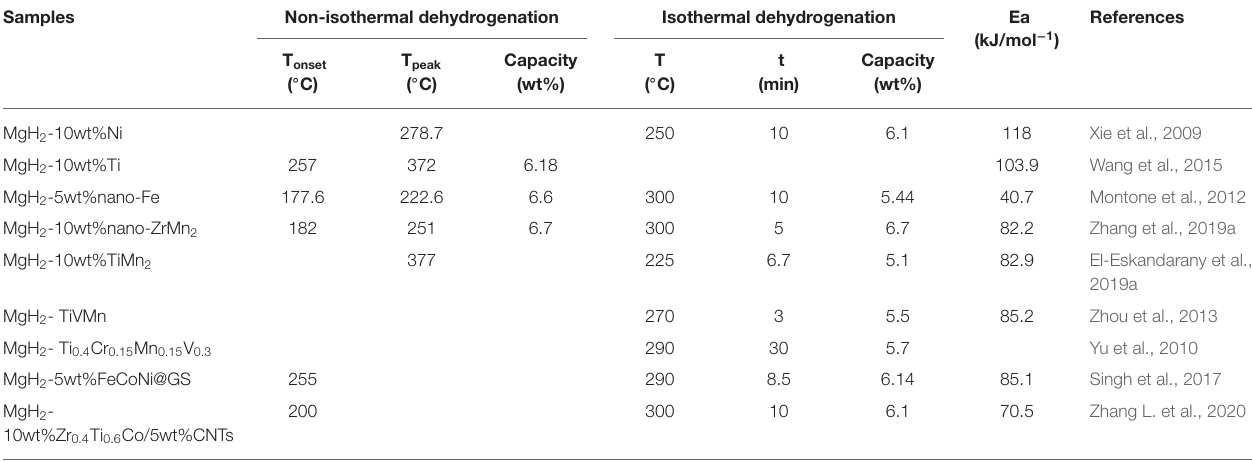
TABLE 1 | Dehydrogenation properties of MgH 2 catalyzed with various materials.